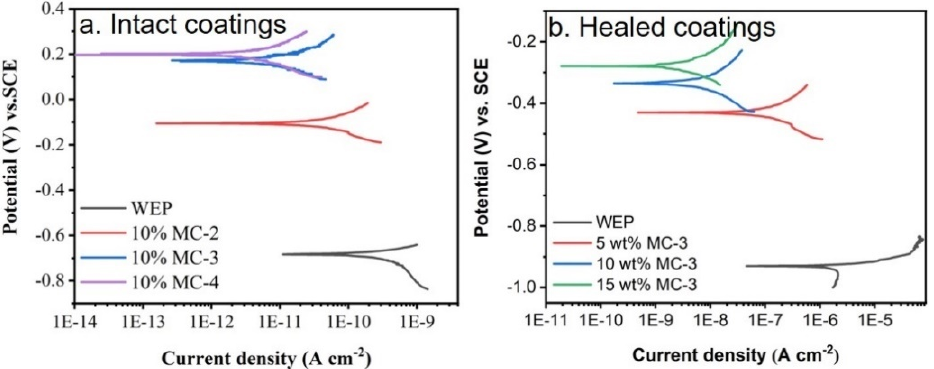
with the neat WEP coatings.